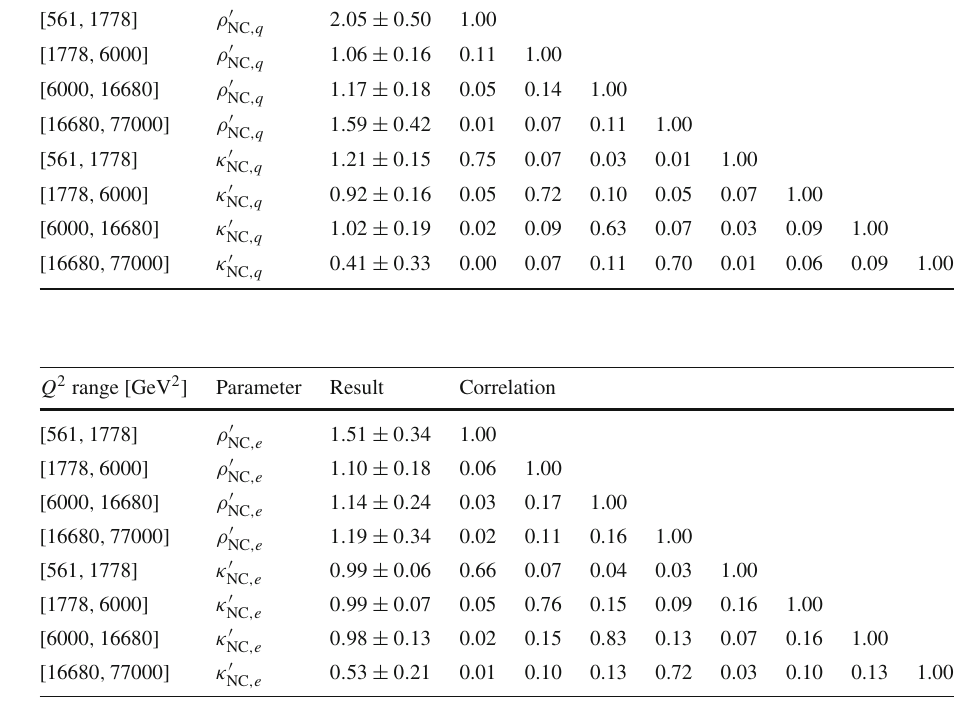
Table 13 Results for the ρ (cid:6) NC , q and κ (cid:6) parameters NC , q determined at different values of Q 2 . The Q 2 range of the data selection, and the correlation coefficients of the fit parameters